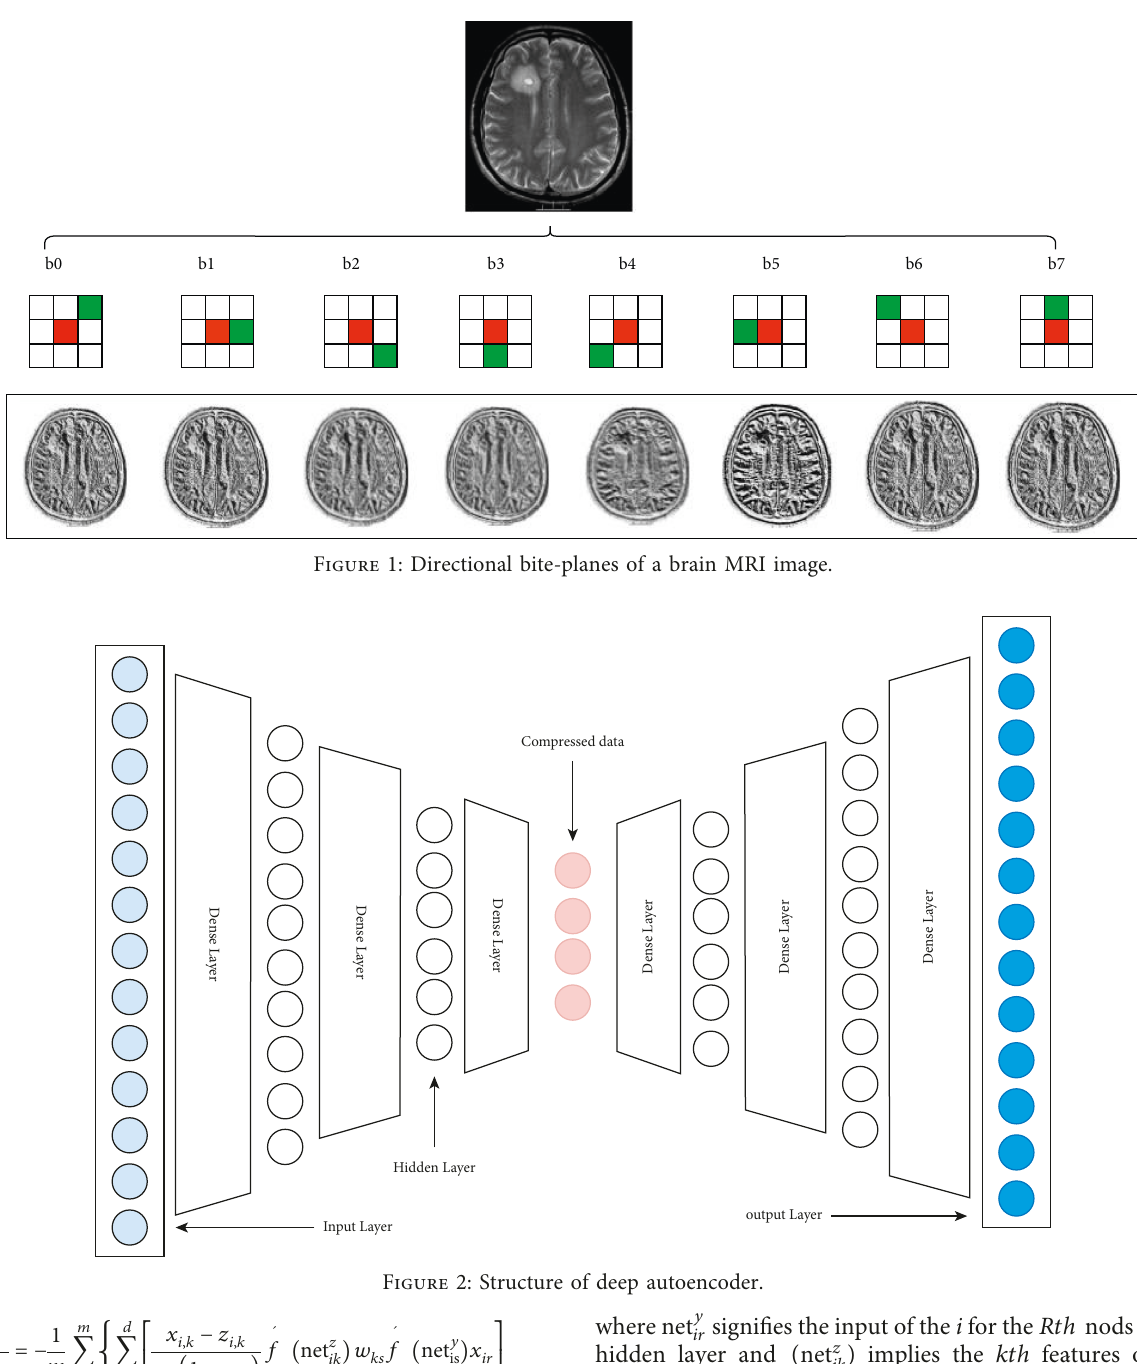
Figure 2: Structure of deep